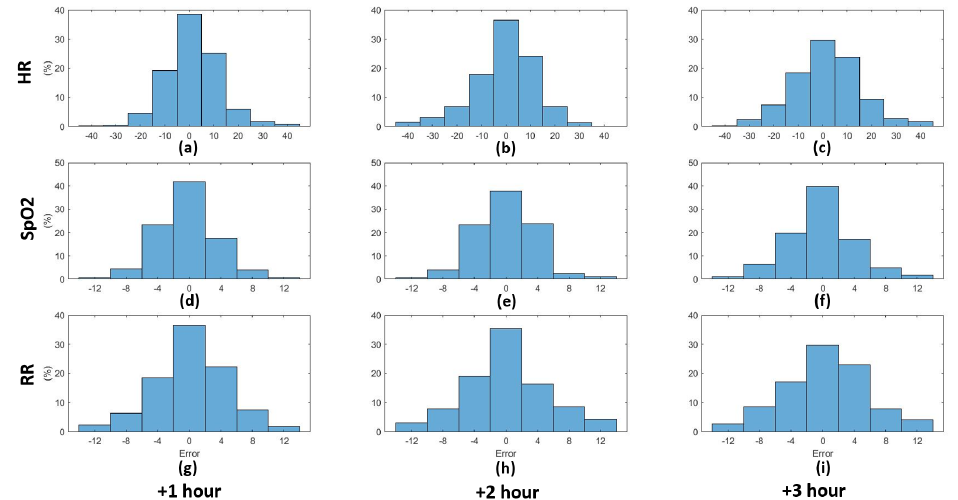
Figure 9. Normalised histograms of the error of the predicted values for the three vital signs for the upcoming three hours based on hourly to bi-hourly observations. Each row represents one of the three vital signs: heart rate, oxygen saturation, and respiration rate respectively. Each column represents the prediction hour: +1, +2, +3 h, respectively. ( a ) HR +1 h, ( b ) HR +2 h, ( c ) HR +3 h,